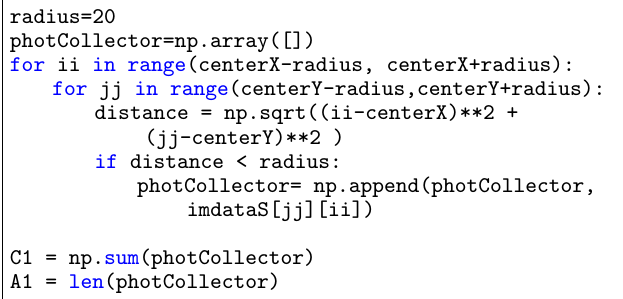
centerX = 1819 centerY = 1215 plt.xlim(centerX-100,centerX+100) plt.ylim(centerY-75,centerY+75)